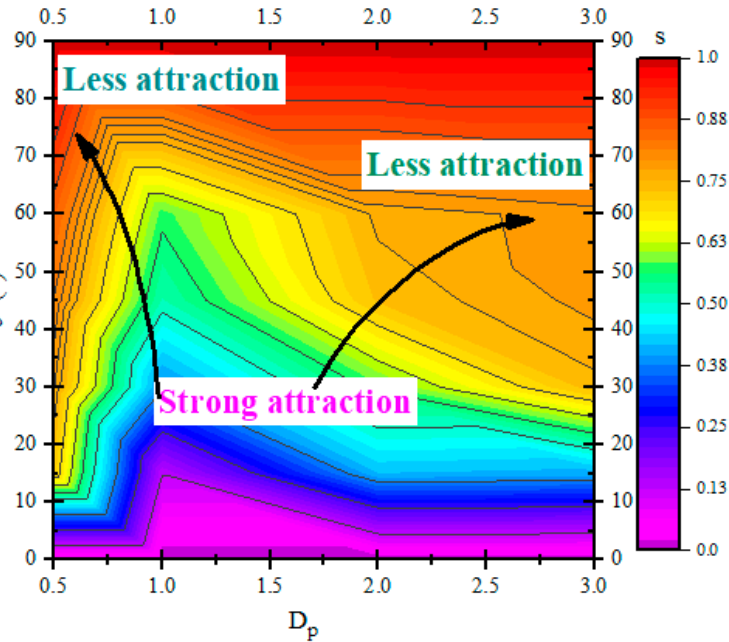
Figure 16. Contour maps of dimensionless minimum separation for different angles and initial surface-to-surface distances.